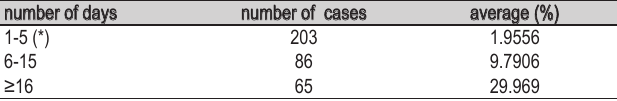
Table 6 - Distribution of the number of absentee days in relation to the number of